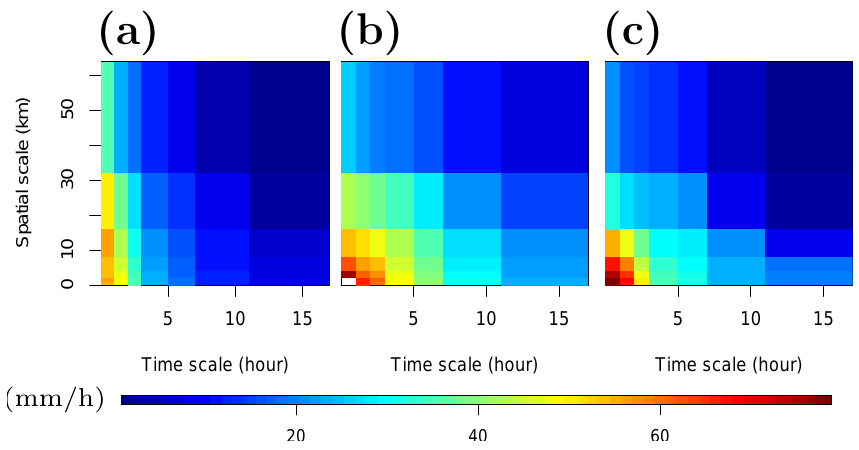
Fig. 11. Maxima diagrams: maximum observed rainfall intensities (mmh − 1 ) as a function of accumulation duration and area, for (a) Case 1, (b) Case 2 and (c) Case